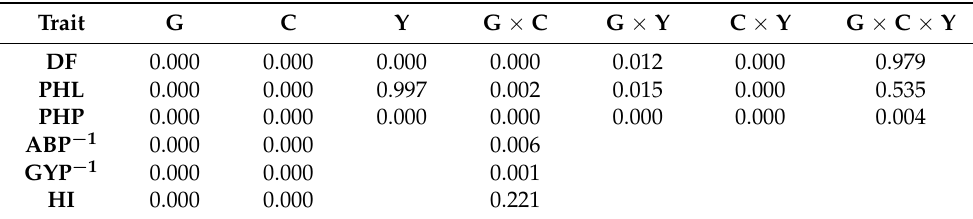
Table 3. Summary of the analysis of variance (ANOVA) for the effects of genotype (G), condition (C), year (Y), and their possible interactions on rice phenotypic traits. Trait G C Y G × C G × Y C × Y G × C × Y DF 0.000 0.000 0.000 0.000 0.012